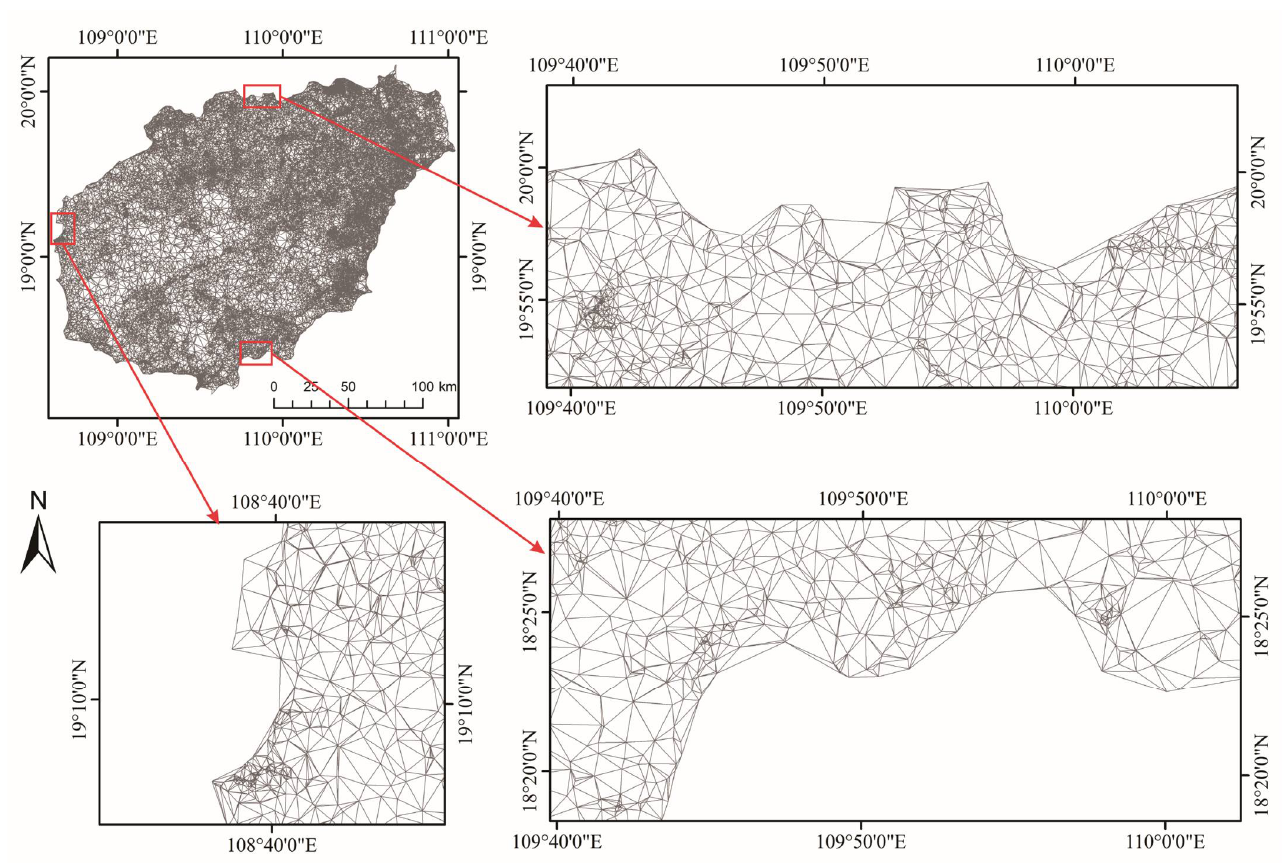
Figure 6. TIN example: overall TIN shape of Hainan Island and three enlarged examples of areas for display.